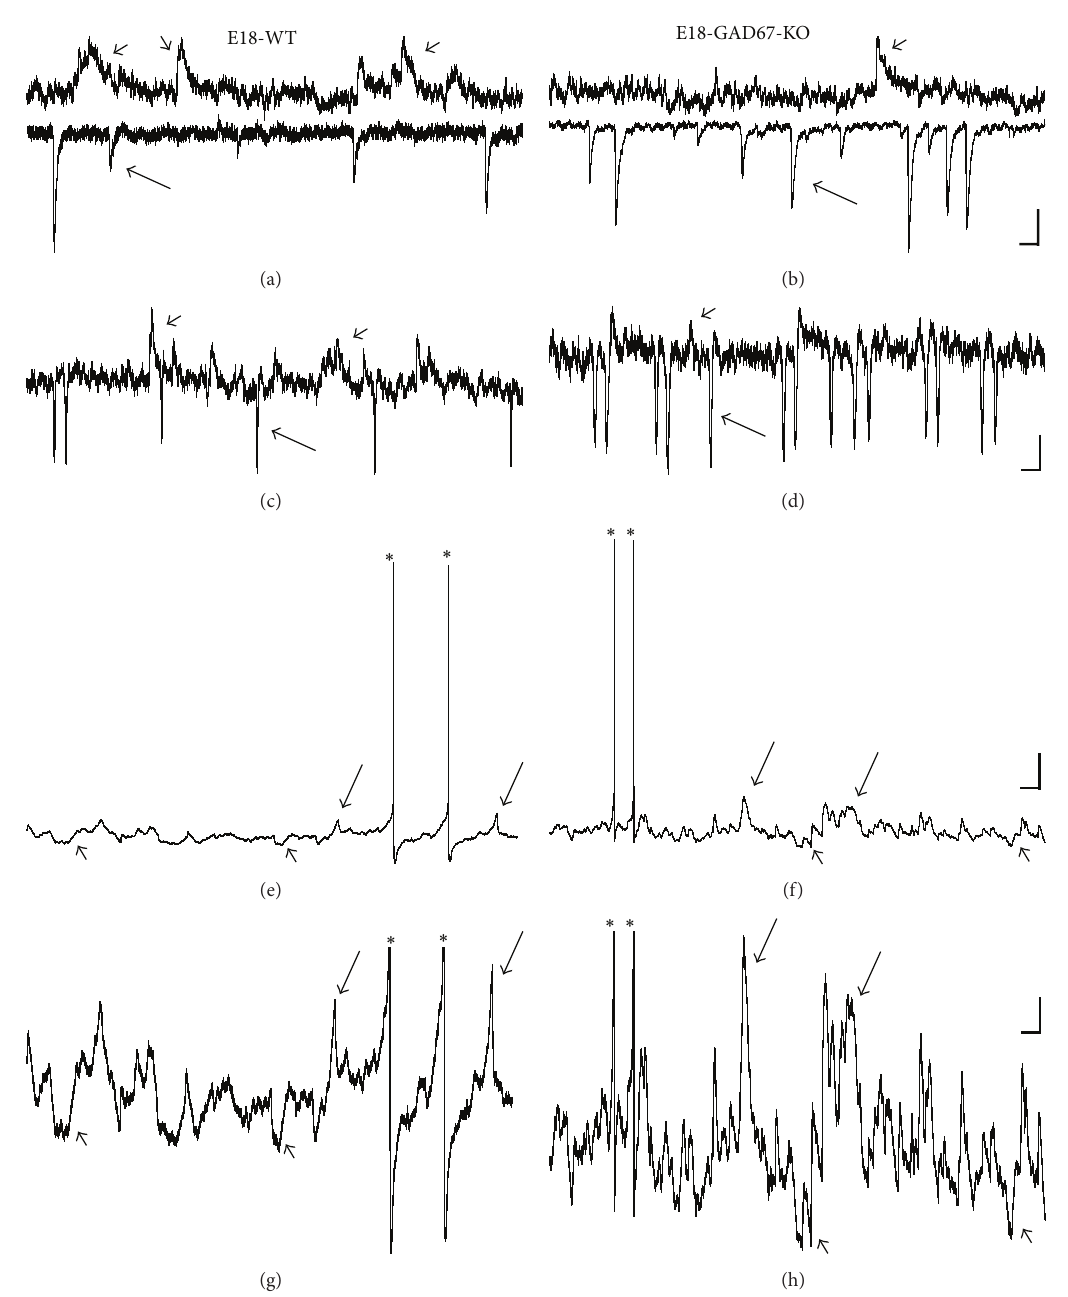
Figure 4: Electrophysiological recordings of hypoglossal motoneurons from C57/Bl6 WT mice compared to GAD67-KO mice at E18 (for methodology see Kanjhan and Bellingham, 2013 [26]). (a-b) Somatic recordings of excitatory (downward deflections, long arrows, EPSCs) and inhibitory (upward deflections, short arrows, IPSCs) postsynaptic currents using low resistance electrodes (3-4 m Ω ) at − 60 mV and 0mV holdingpotentials,respectively.(c-d)DendriticrecordingofEPSCs(downwarddeflections,longarrows)andIPSCs(upwarddeflections,short arrows) at 0 mV holding potential using higher impedance electrodes (10–15m Ω ). (e-f) Current-clamp recording of membrane potential at action potential ( ∗ ) firing threshold, showing subthreshold excitatory (long arrows, EPSPs) and inhibitory (short arrows, IPSPs) postsynaptic potentials. (g-h) Magnified baseline traces of (e)-(f), respectively. Scale bars = (a-b) = 50 pA, 0.1 s; (c-d) = 25 pA, 0.1 s; (e-f) = 20 mV, 1s; and (g-h) = 3mV,